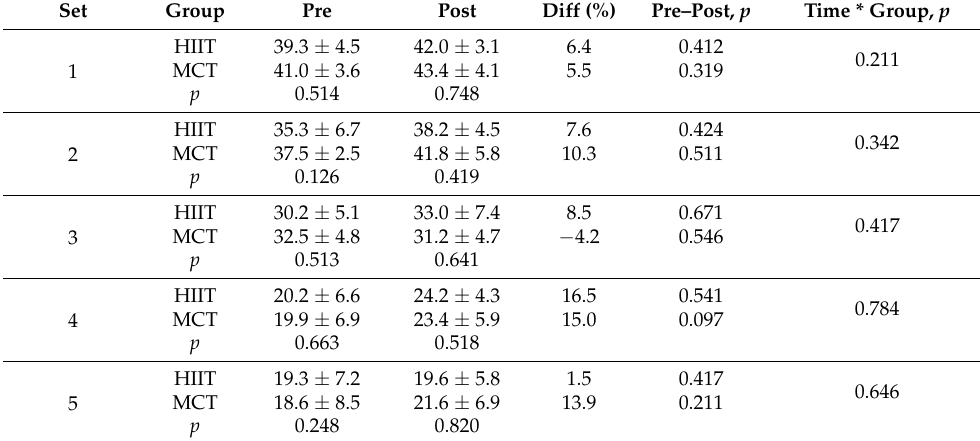
Table 6. Heart rate after the Wingate